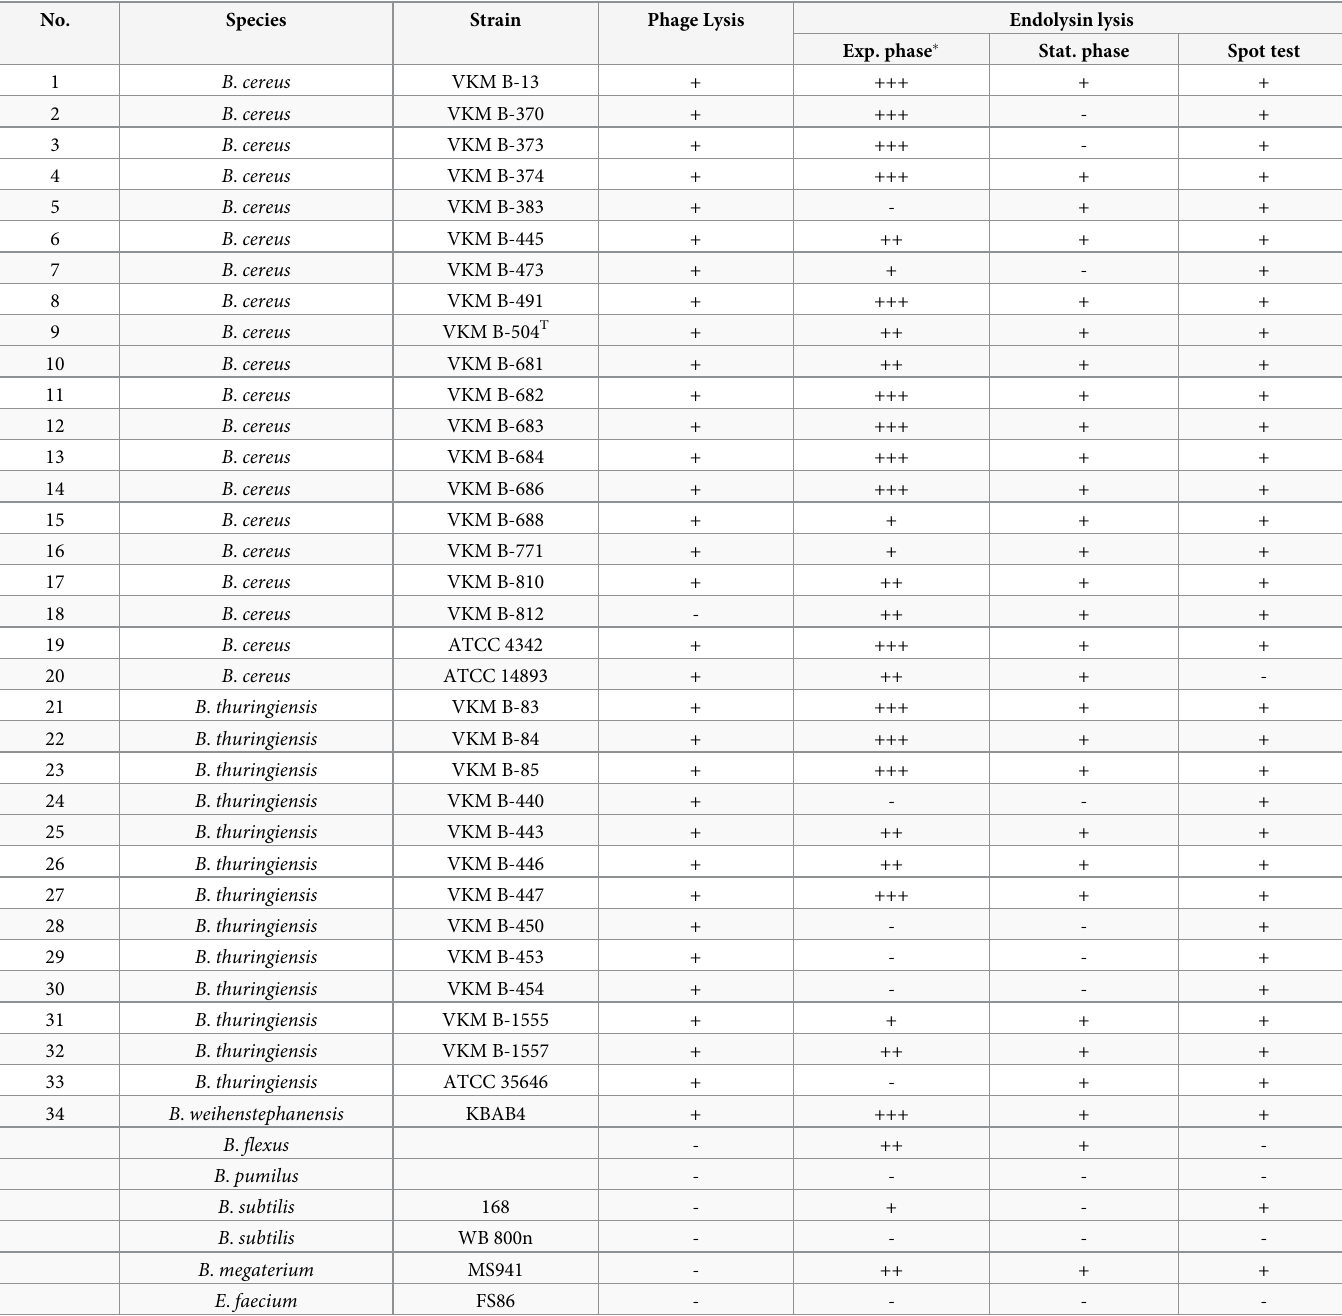
Table 1. The host range of phage Izhevsk and the lytic spectrum of its endolysin determined on 34 different Bacillus cereus sensu lato strains.